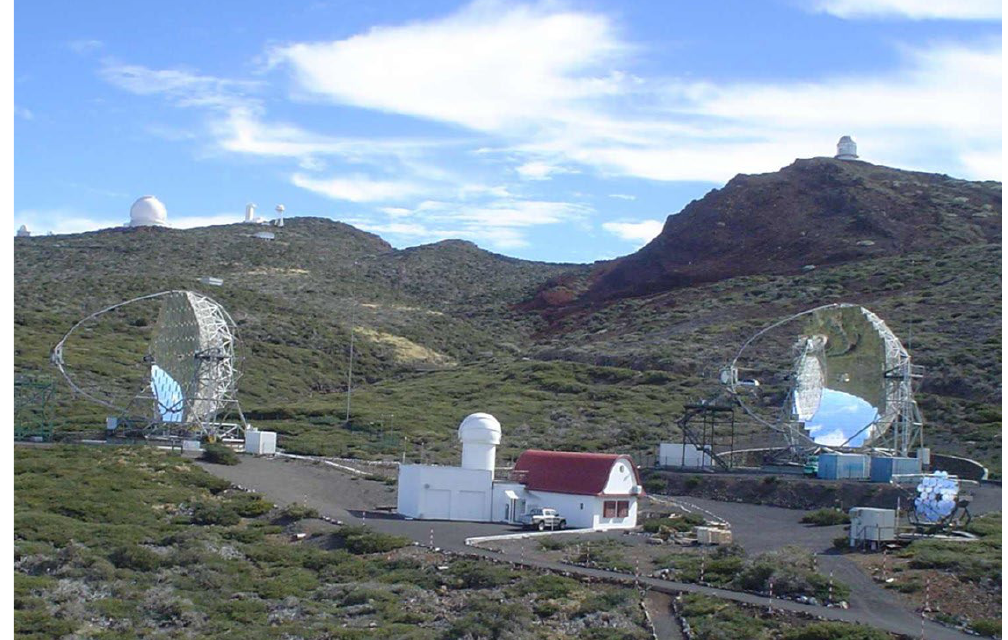
Figure 6. The two 17 m diameter MAGIC IACTs at the ORM observatory in La Palma. In the center one can see the experimental house. The white dome on top of the garages harbors the LIDAR instrument. In the top left corner one can see the famous 4.3 m diameter William Herschel telescope. The 2.5 m diameter Nordic optical telescope is located on the top-right summit. In the lower right corner one can see the 4 m FACT telescope.